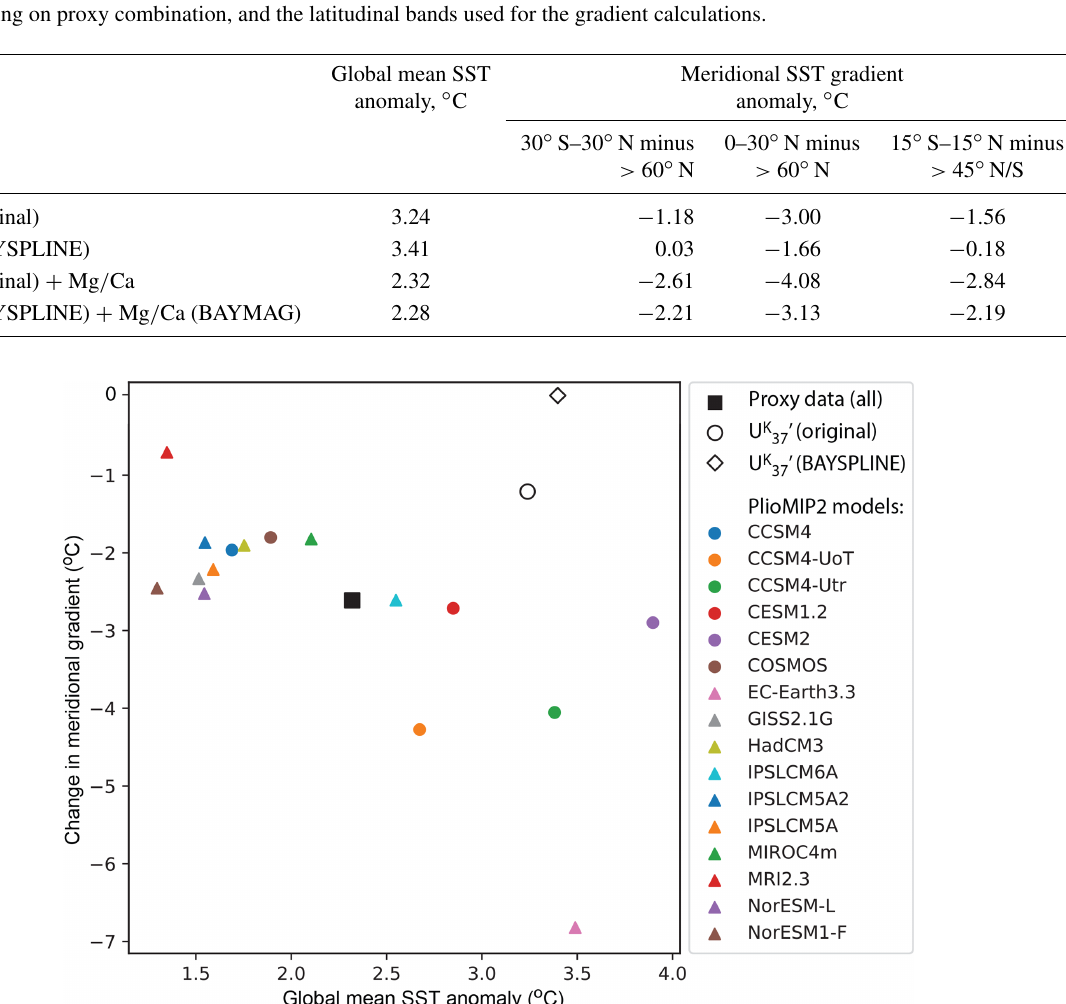
Figure 3. Comparison of KM5c SST data relative to the pre-industrial period (NOAA-ERSST5) for global mean SST anomalies (SSTA) and the change in meridional SST gradient, constructed using proxy data and the suite of PlioMIP2 models. Details of the model experiments are outlined in Table 1 of Haywood et al. (2020). The meridional SST gradient is calculated as 30 ◦ S–30 ◦ N minus 60–75 ◦ N, so that a more negative change in the gradient reflects a larger warming anomaly at high latitudes relative to low latitudes. As we only had data points poleward of 65 ◦ N in the Atlantic Ocean, the high-latitude region for both proxy and model gradient calculations focuses on the longitudinal (cid:48) window from 70 ◦ W to 5 ◦ E. Proxy data calculations were made using either all proxy data (U K and Mg / Ca using their original calibrations) 37 (cid:48) or using only U K data and comparing the original and BAYSPLINE calibrations. No Mg / Ca data are available > 60 ◦ N, so we were 37